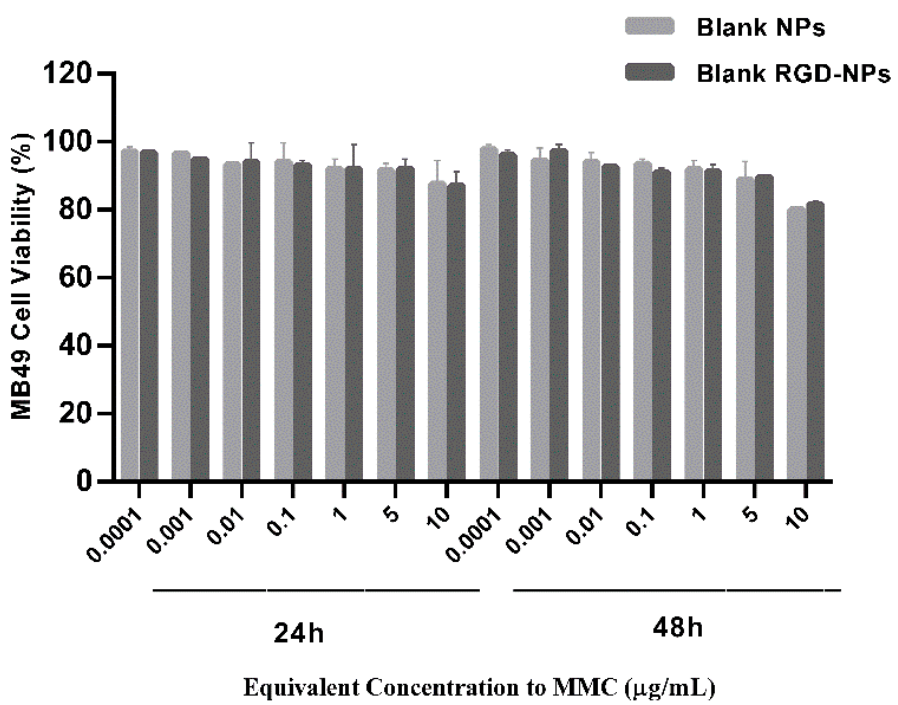
Figure 8. Cytotoxicity of blank NPs and blank RGD NPs after incubation for 24 and 48 h against MB49 cells ( n = 6).